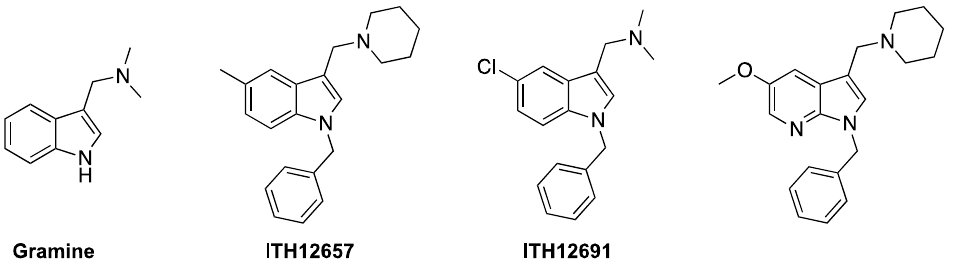
Figure 10. Highlighted gramine derivatives with important PAD activity.